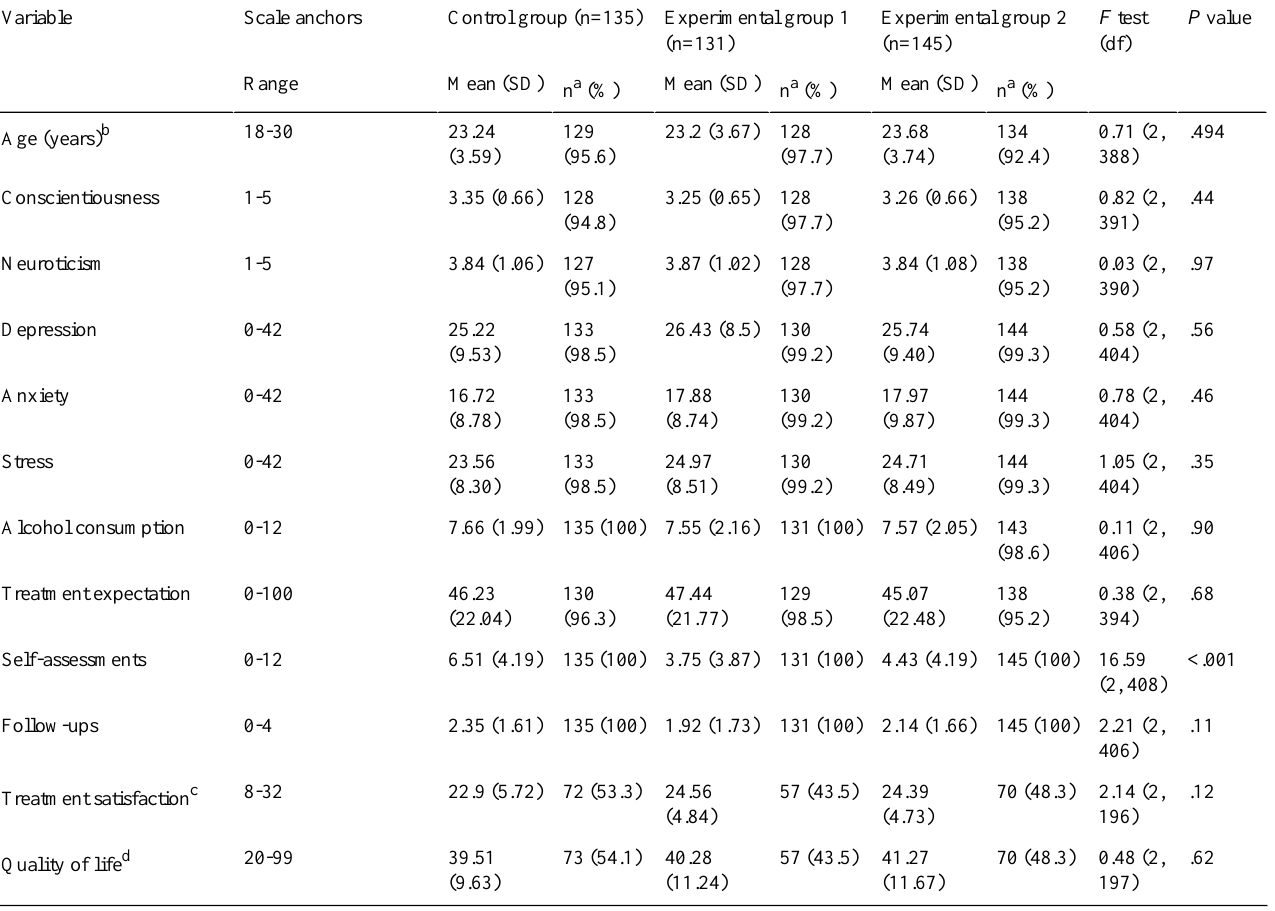
Table 1. Scale response anchors: means, SDs, and between-group statistics on key variables.